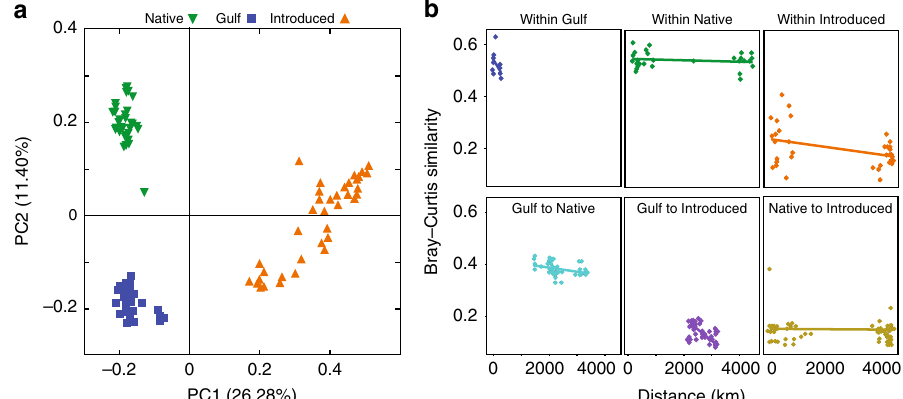
Fig. 1 Differences in microbial community structure among lineages and as a function of distance between sampling locations. a Principal coordinates analysis of Bray – Curtis dissimilarity for the microbial communities associated with Native ( green ), Gulf ( blue ) and Introduced ( orange ) lineages of Phragmites australis , collected from across the United States (Supplementary Fig. 1). b Bray – Curtis dissimilarity plotted as a function of the distance (km) between sampling locations. Regression statistics are found in Supplementary Table 2. n = 5 replicates per P. australis population (eight